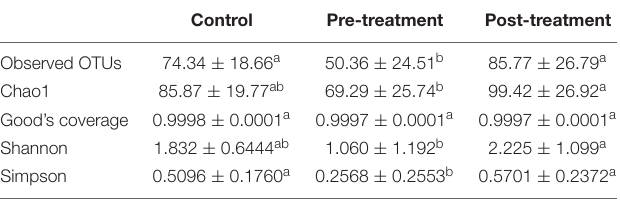
TABLE 3 | ITS sequencing parameters of three groups. Control